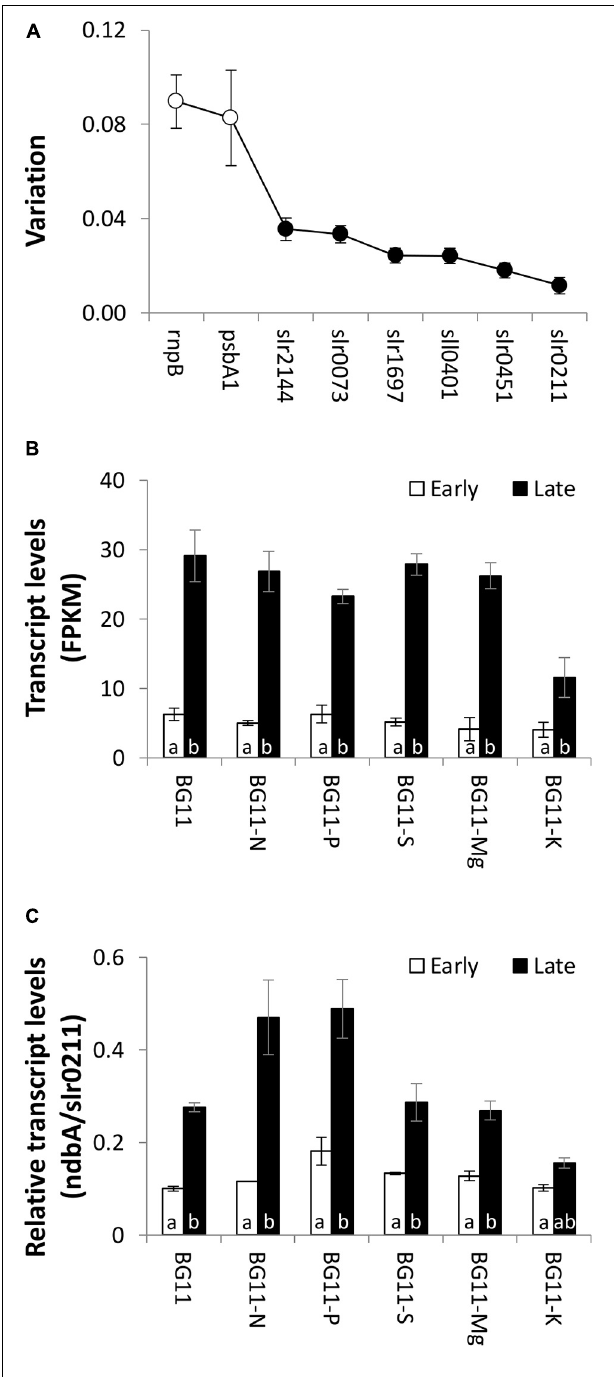
FIGURE 3 | Native ndbA transcript levels. (A) Variation of Ct values determined using NormFinder software (Andersen et al., 2004). qPCR was performed with 36 samples representing the early and late growth phases of three independent cultures of Synechocystis cultivated under control (BG11) and low nutrient conditions (12.5% N, P, S, Mg, or K in BG11 background). White circles represent reference genes used in other studies (Foster et al., 2007; Pinto et al., 2012). Black circles represent genes selected from the RNA sequencing dataset based on low standard error. Data are means ± S.E.M. of three independent cultures. slr0211 was selected as reference gene for further (Continued)